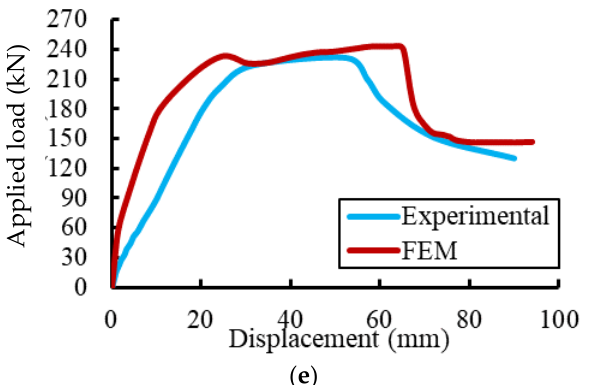
Figure 14. Comparison between FE and experimental deformations. ( a ) Specimen Ref. ( b ) Specimen EG. ( c ) Specimen EGS. ( d ) Specimen EGW. ( e ) Specimen EGSW.